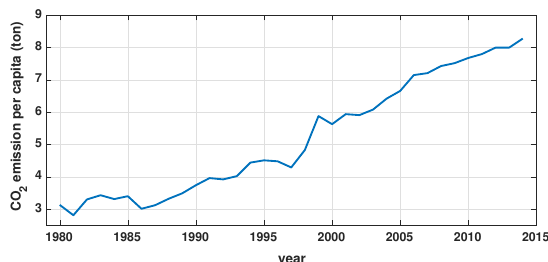
Figure 9. CO 2 emission per capita of